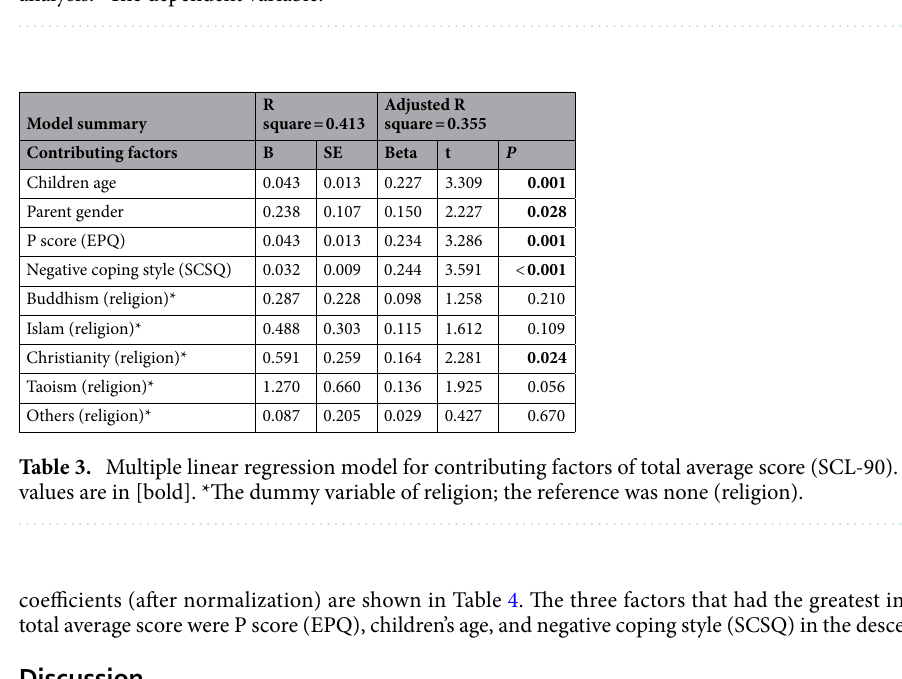
Table 2. Result of scales and univariate analysis. Significant values are in [bold]. a The result of univariate analysis. *The dependent variable.